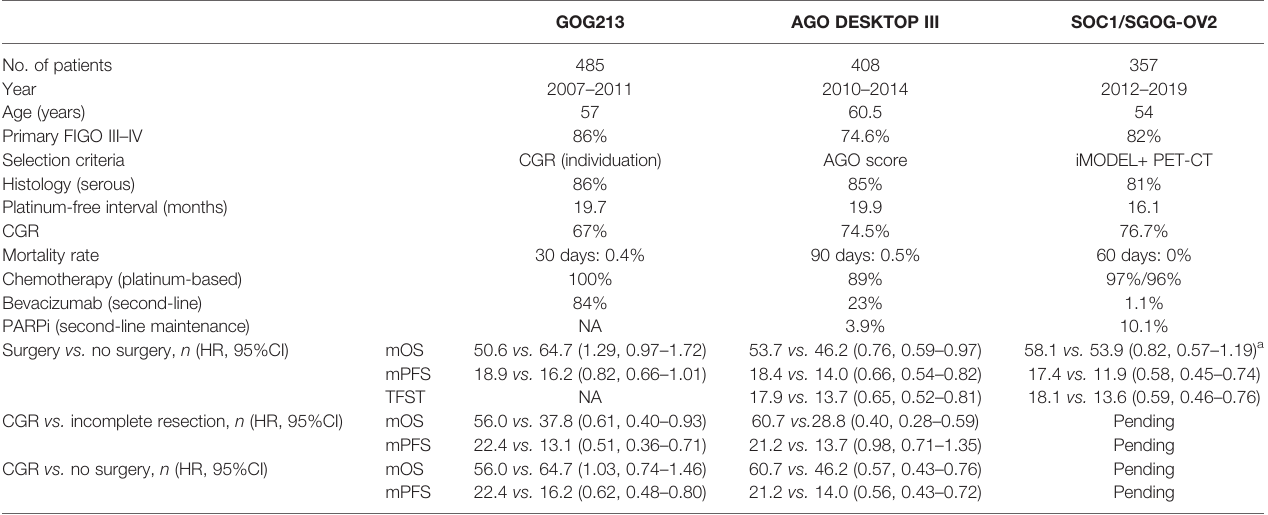
FIGO,InternationalFederationofGynecologyandObstetrics;CGR,completegrossresection;PARPi,poly-ADPribosepolymeraseinhibitor;HR,hazardratio;TFST,timetostartofthe fi rst subsequent therapy; NA, not applicable; mOS, median overall survival; mPFS, median progression-free survival. a Results of the interim overall survival